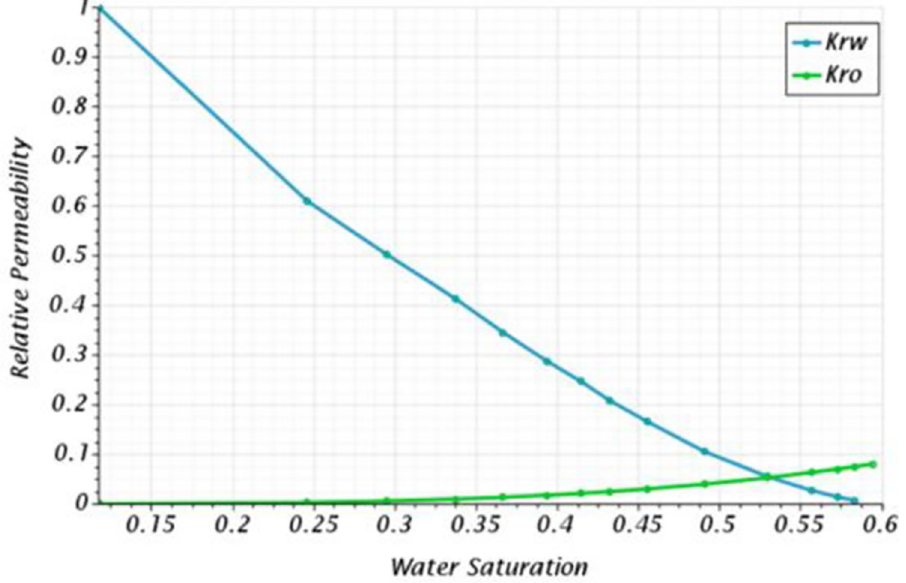
Fig 3. Relative permeability curve measured from the core analysis of the studied